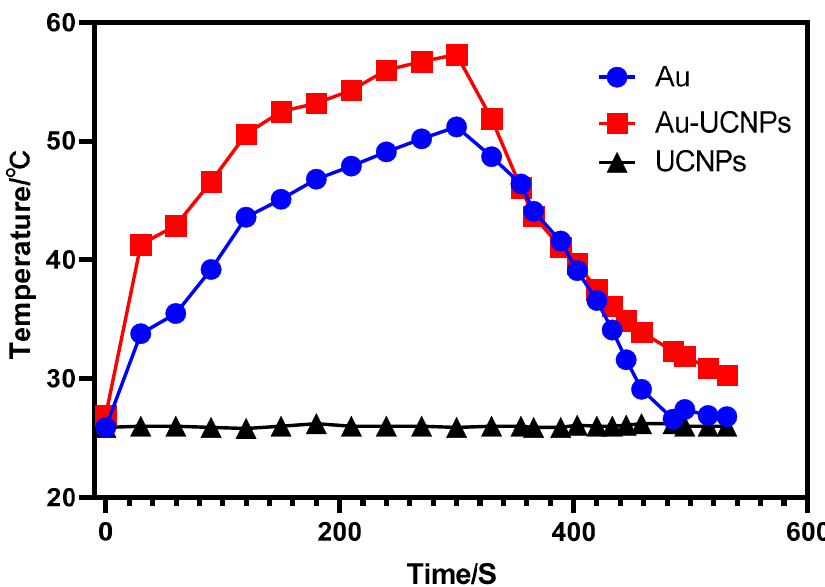
Figure 1. Temperature rise and drop curves of gold nanoparticles (blue) irradiated by near-infrared light at a 540 nm wavelength; UCNPs (black) and Au-UCNPs (red) irradiated by near-infrared light at a 980 nm wavelength.